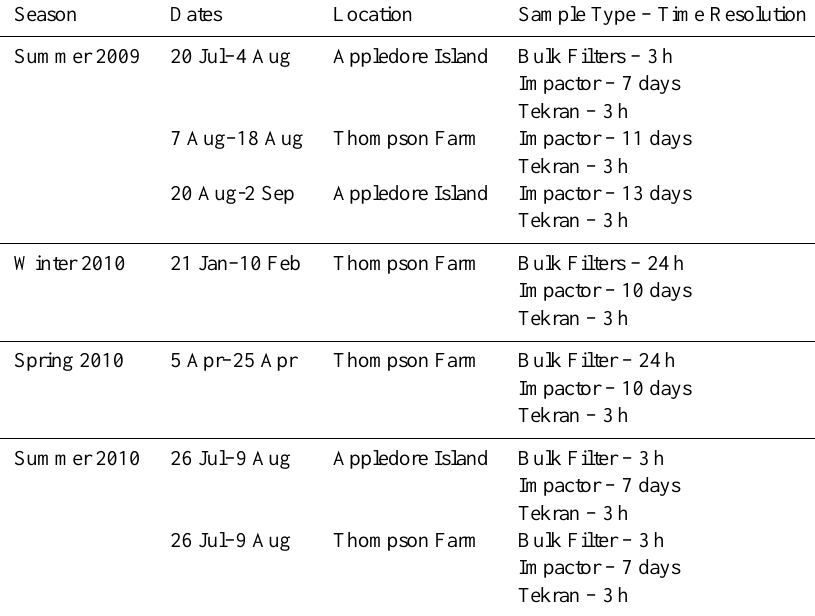
Table 1. Sampling Details for Hg P .